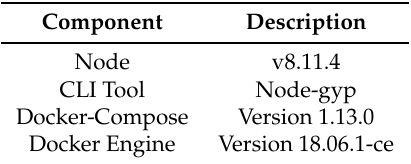
Table 5. Hyperledger Caliper environmental setup.